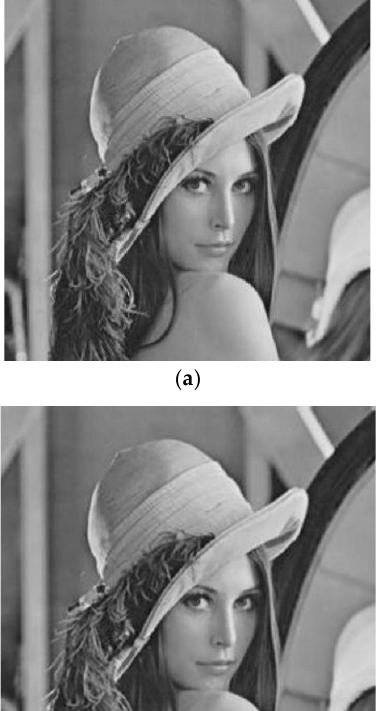
Figure 2. The original Lenna Image.